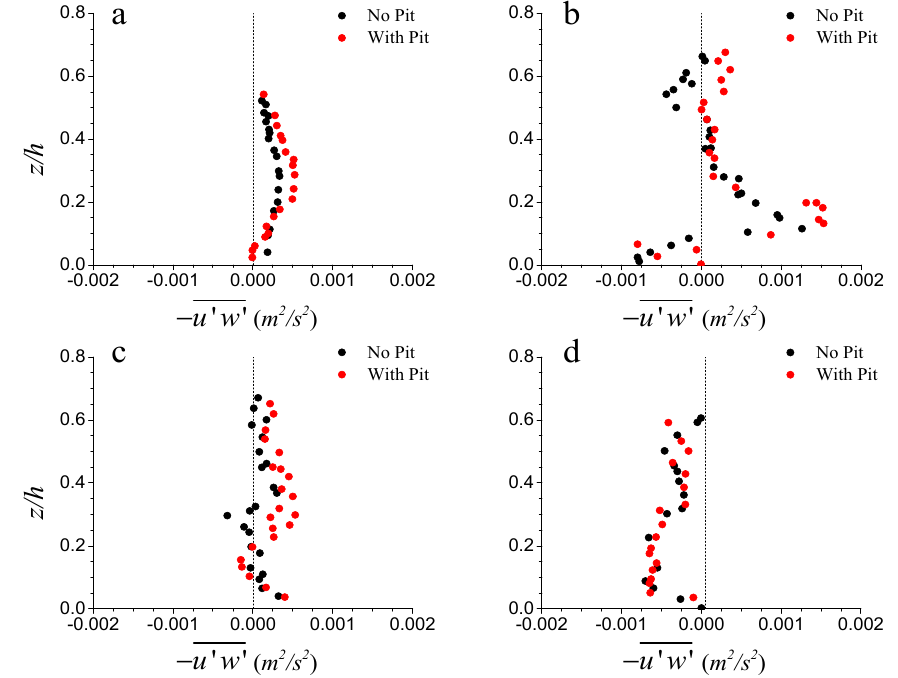
Figure 5. Streamwise Reynolds Shear Stress profiles at ( a ) Location-# 1, ( b ) Location 2, ( c ) Location 3, and ( d ) Location 4.